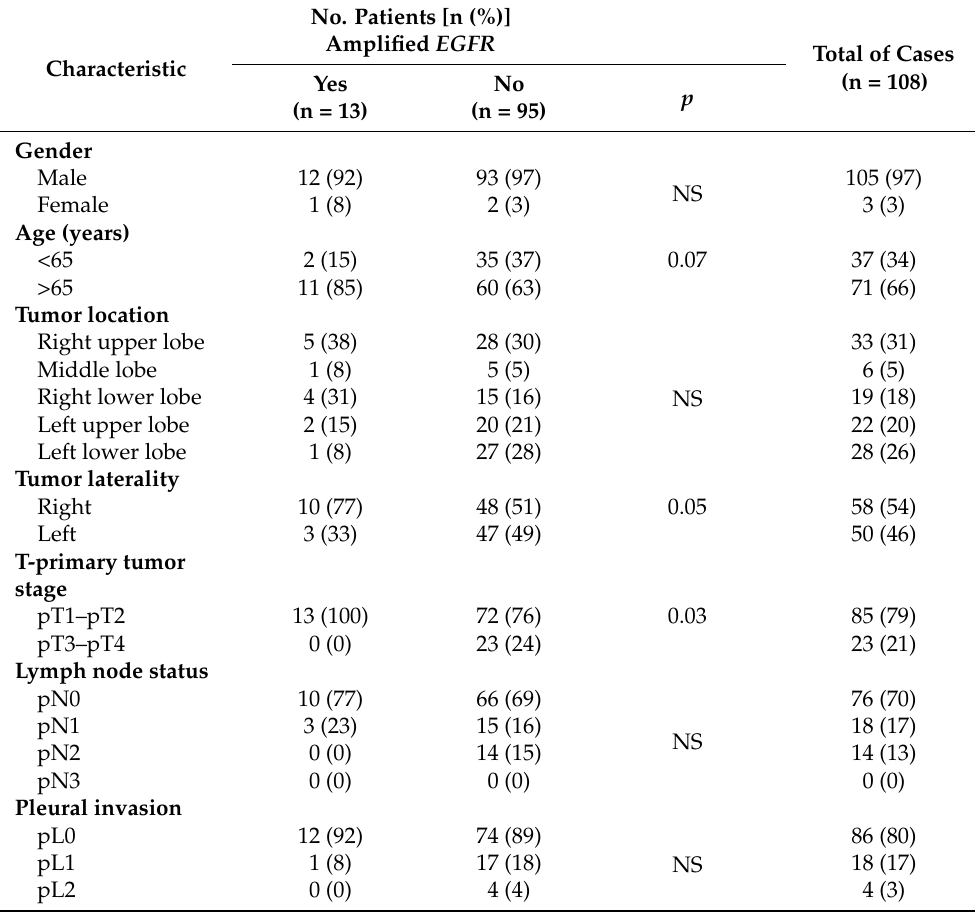
Table 3. Clinical, histopathological, and biological disease characteristics of squamous cell carcinomas of the lung (SCC), according to the number of copies of EGFR gene detected by FISH techniques (n = 108).